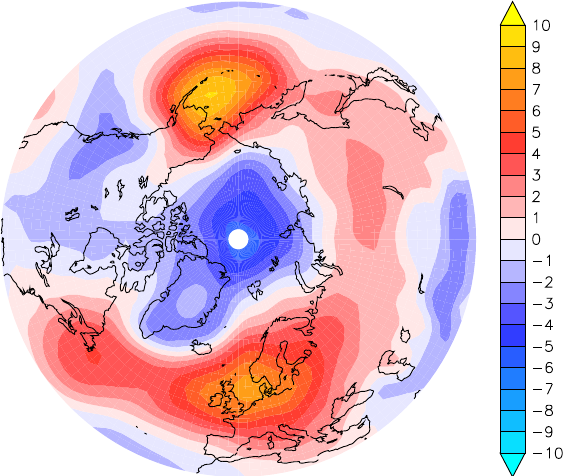
Fig. 13. DJF surface pressure difference (hPa) 1p = p S − EPP − p S − noEPP , SSW years excluded. Red-yellow/blue colours indicate positive/negative